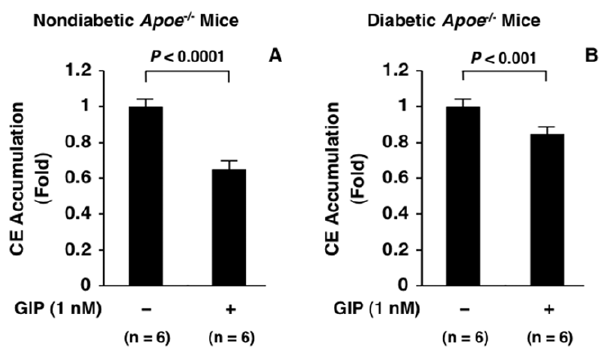
Figure 7. In vitro suppressive effects of GIP on foam cell formation in exudate peritoneal macrophages from nondia- betic and diabetic Apoe 2 / 2 mice. Exudate peritoneal macrophages were obtained from 6 nondiabetic Apoe 2 / 2 mice (A) and 6 STZ-induced diabetic Apoe 2 / 2 mice (B) by intraperitoneal injection of thioglycolate, and were incubated with or without GIP (1 nM) for 24 hours followed by addition of oxLDL (10 m g/ml) for 18 hours. Foam cell formation was evaluated by oxLDL-induced CE accumulation in macrophages. Assays were performed in duplicate. 1 fold=15.6 6 1.5 nmol/mg cell protein (A) and 13.8 6 1.0 nmol/mg cell protein (B).